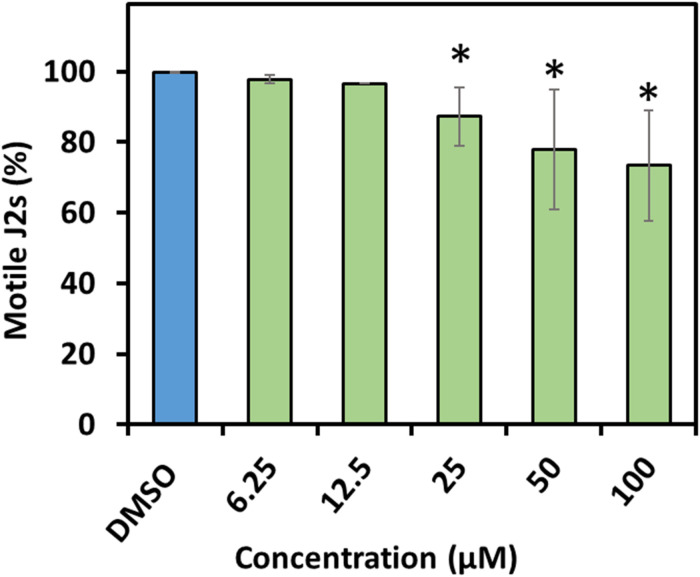
Recovery of second stage juveniles of H. schachtii after exposure to prodigiosin (1). Percentage of recovered nematodes after 48 h incubation in prodigiosin (1) followed by washing and incubation for 48 h in water. Values are means ± standard error of three biological replicates (n = 9). Asterisks indicate significant differences to the control based on one-way ANOVA followed by Dunnett’s post-hoc test (P < 0.05).